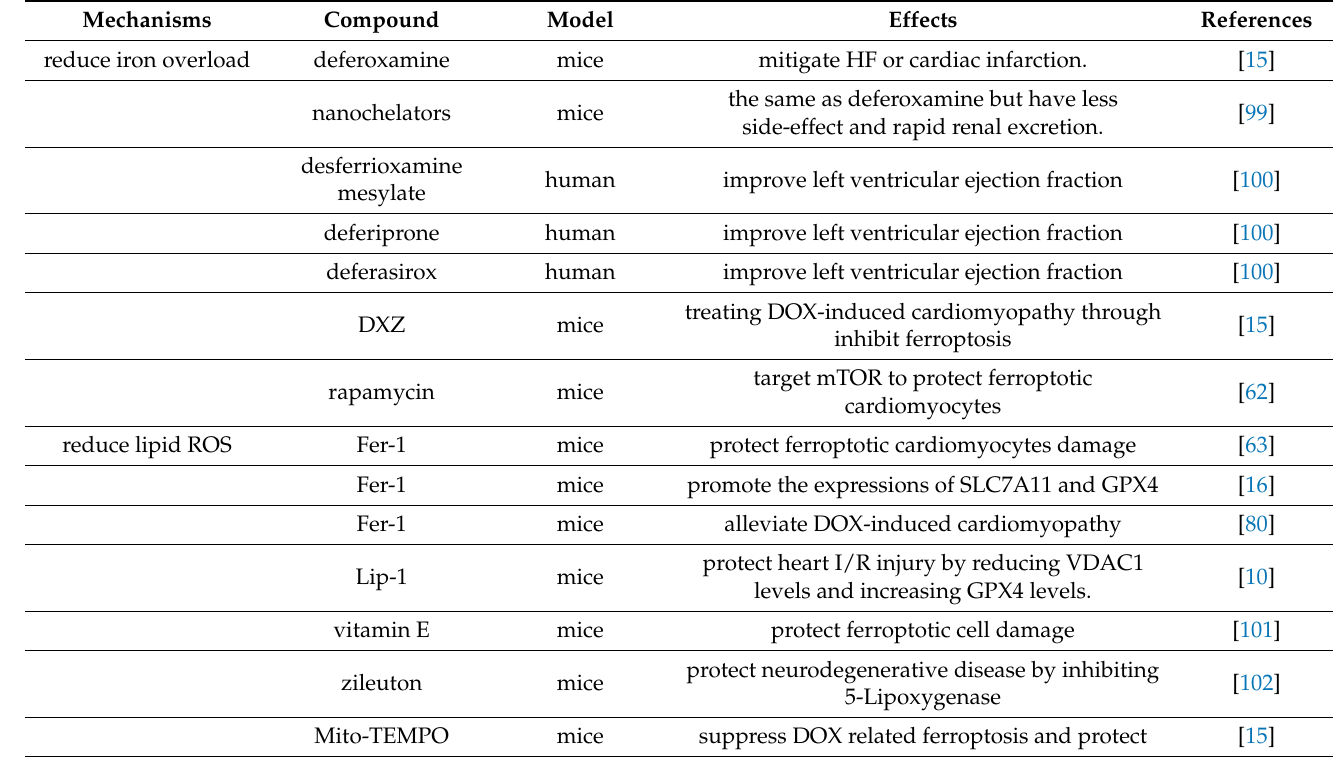
Table 2. Pharmacologic compounds modulating ferroptosis in cardiovascular